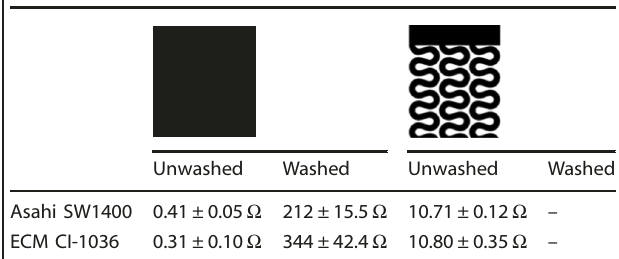
Table 3. The resistance of the different shape electrodes (full coverage and horseshoe) after the washing